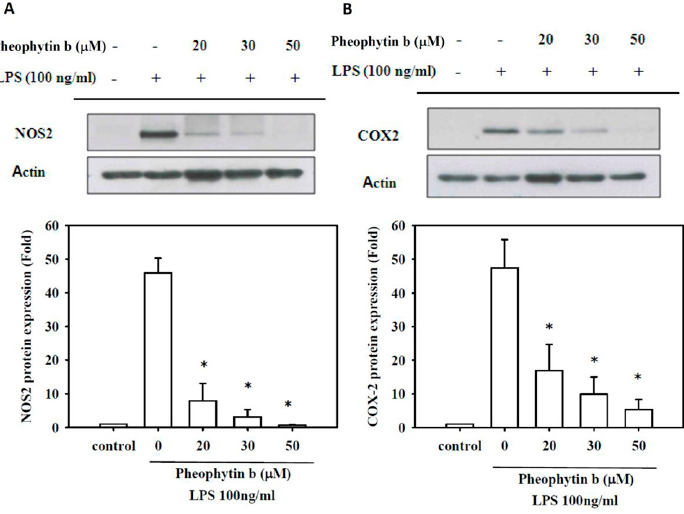
Figure 3. Pheophytin-b suppressed NOS2 and COX-2 protein synthesis in LPS-stimulated RAW 264.7 cells. Cells were pre-treated with the indicated concentrations of pheophytin-b for 30 min and stimulated with LPS for 6 h. NOS2 ( A ) and COX-2 ( B ) protein levels were determined by Western blot analysis, quantified, and normalized to those of the control group. Bottom panels show the fold-change compared to the control group (without LPS stimulation). Actin levels were analyzed as a control to ensure equal loading. * p < 0.05 vs. LPS-treated cells (by Student’s t -test, n = 3).